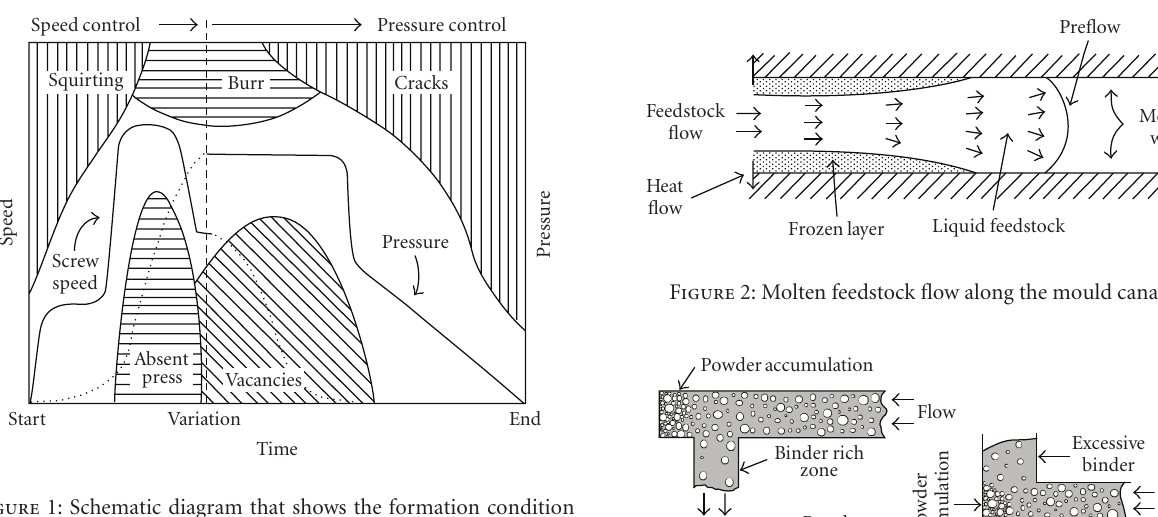
Figure 1: Schematic diagram that shows the formation condition of rate and press control according to the time for mould defects [2].